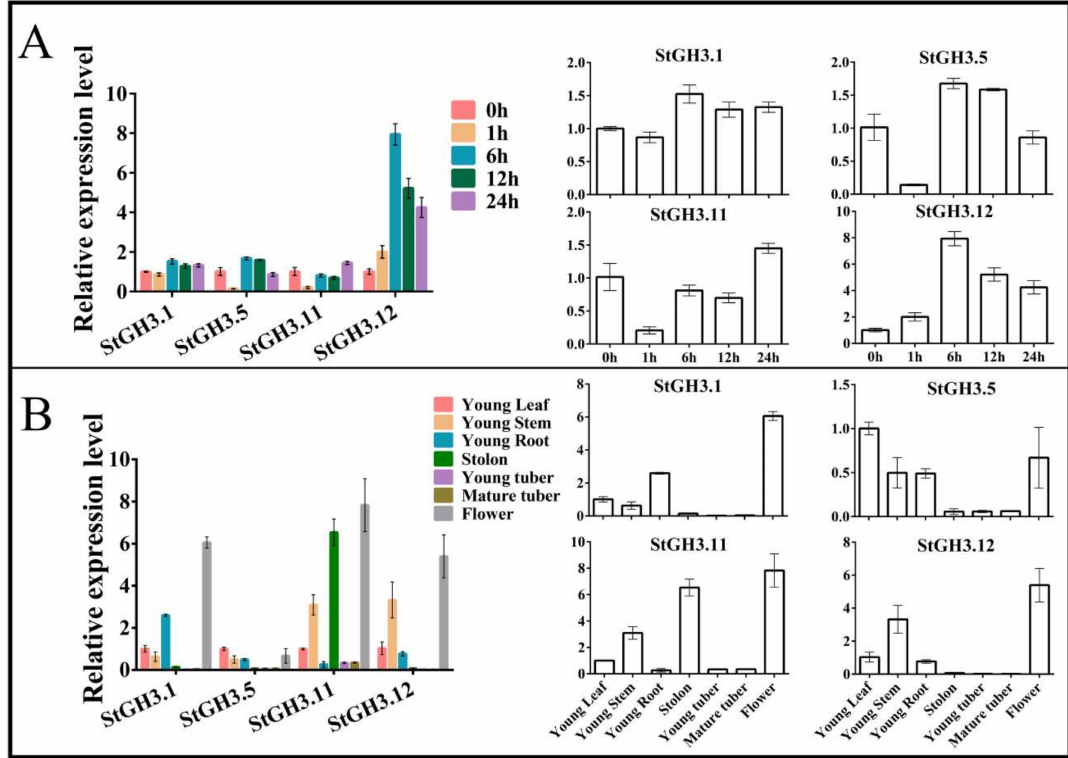
Figure 6. StGH3 gene expression in different tissues and expression changes upon MeJA treatment for different time periods. ( A ) Expression changes upon MeJA treatment for different time periods; and ( B ) Expression in different